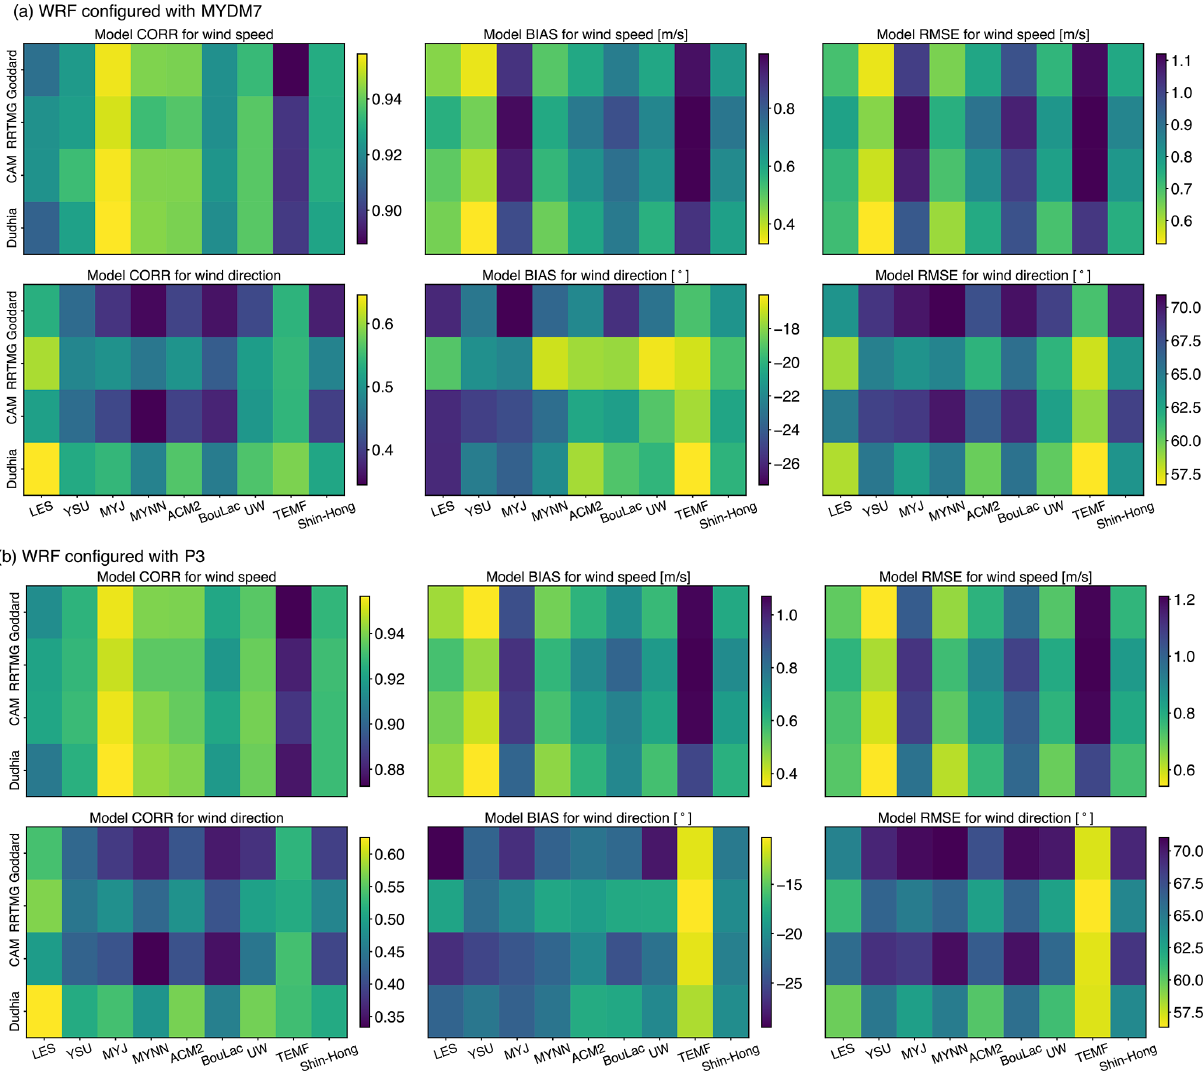
Figure 9. Statistic scores (CORR, BIAS and RMSE) for wind speed and direction for different combinations of PBL and SW–LW schemes, the MP schemes used in panels (a) and (b) are MYDM7 and P3, respectively. Dudhia represents Dudhia–RRTM SW–LW schemes in all the